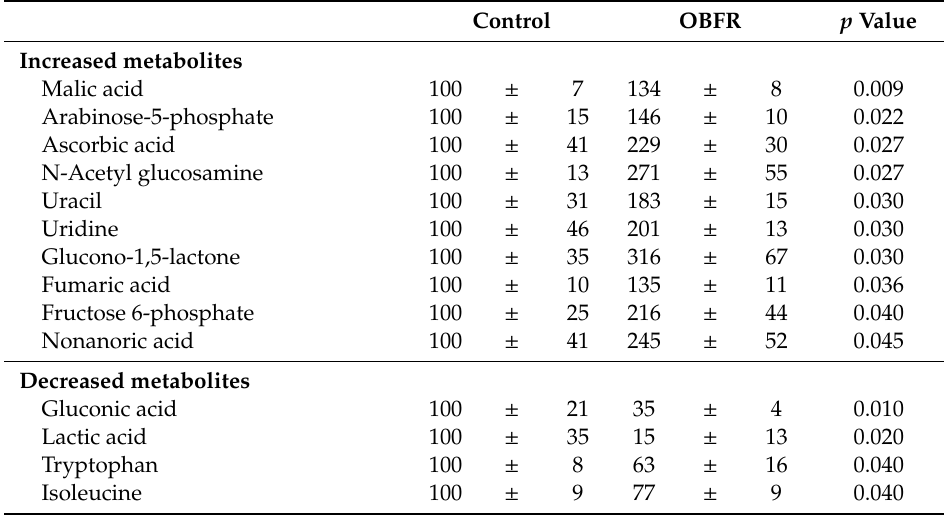
Table 6. E ff ects of feeding OBFR on metabolites in liver of